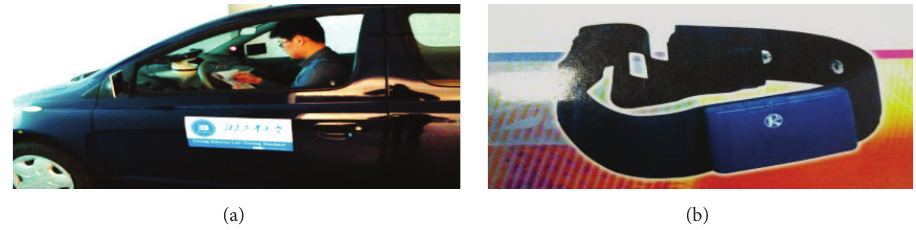
Figure 1: Experiment devices. (a) Driving simulator. (b)